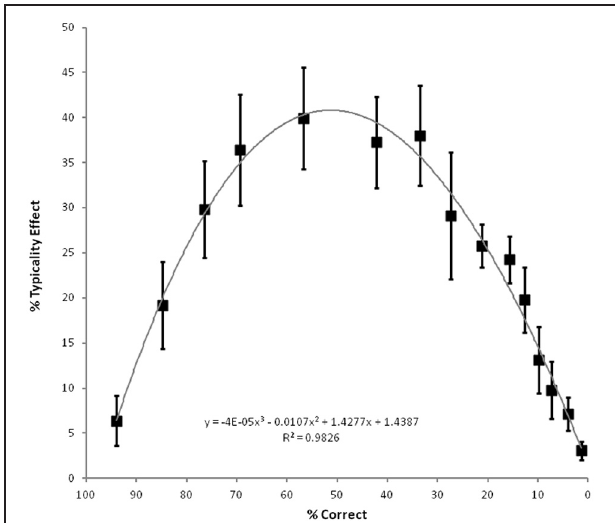
FIGURE 2 | Average magnitude of the concept typicality effect in picture naming accuracy (high typicality minus low typicality) for the 15severity groups of 15 observations each, according to average overall level of accuracy, with cubic regression line and associated equation and fit. Error bars represent ± 90% confidence intervals, hence those points in which they do not encompass the origin correspond to significant effects at an alpha level of 0.05 using a paired one-tailed t -test. Adapted from Figure 2 of Woollams et al., (2008, p.2507).